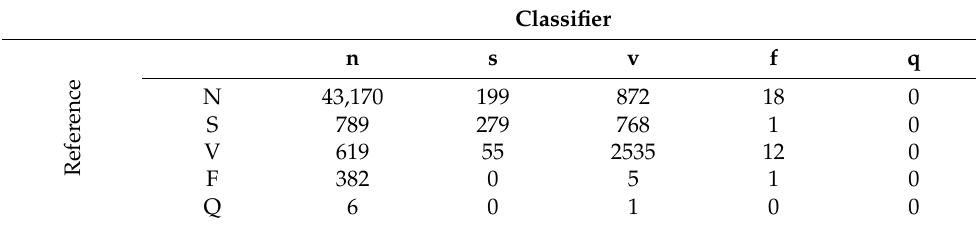
Table 9. Confusion matrix